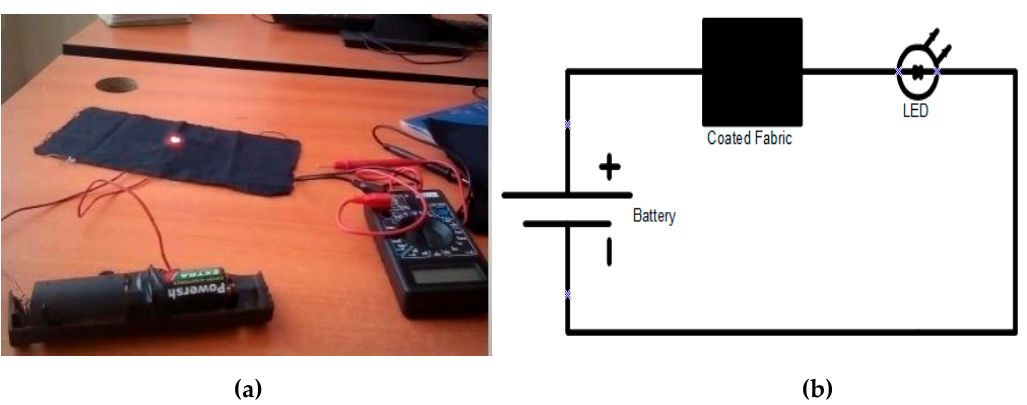
Figure 8. A conductive cotton fabric lights up by light-emitting diode connected with DC power ( a ) and its circuit scheme ( b ).